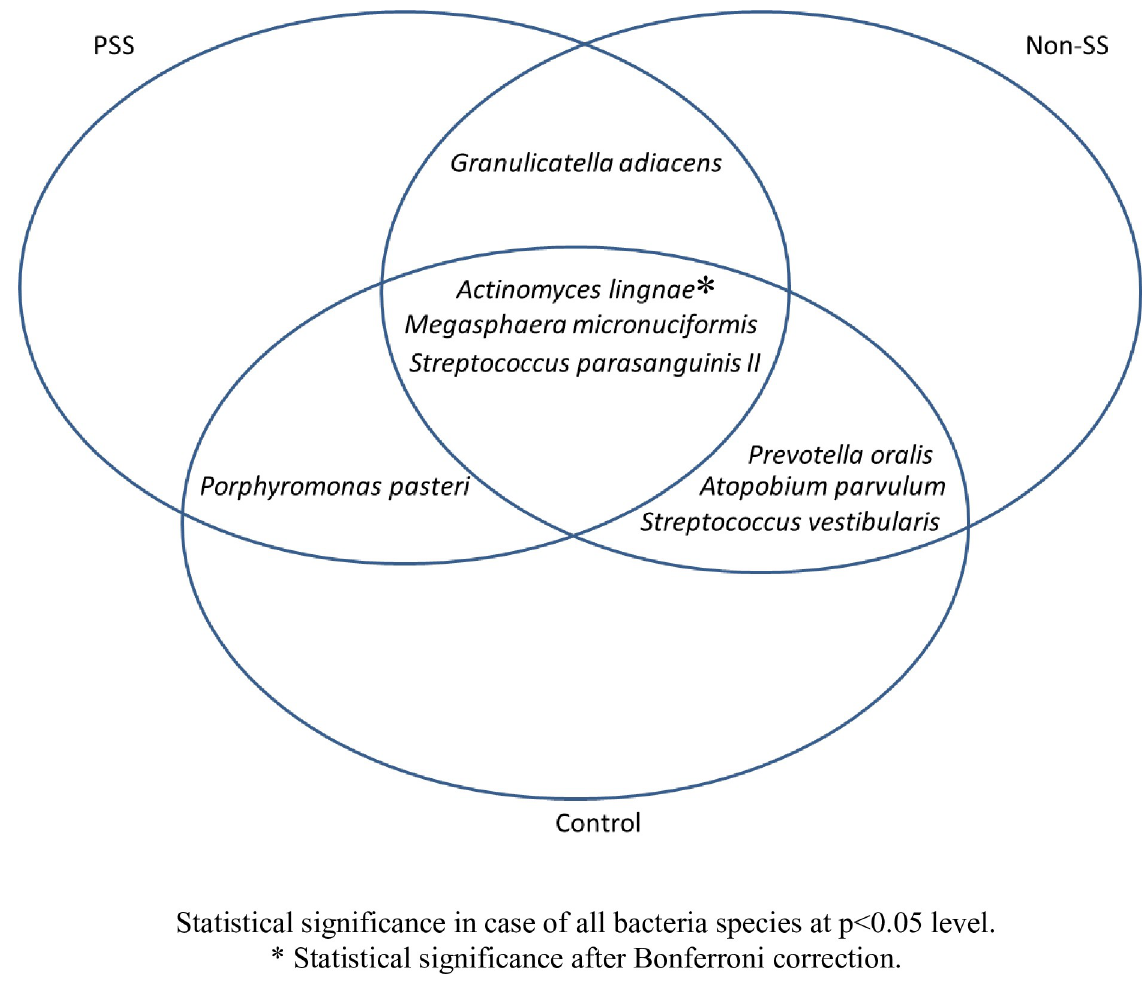
Fig 5. Results of two-sample z-test for the difference between prevalence in the different